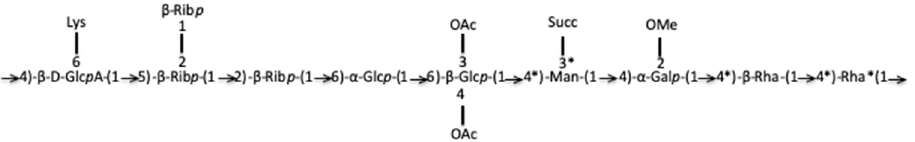
Figure 6. Partial putative structure of the purified EPS obtained from the cysts of R. tataouinensis TTB310. The C*s are those for which it is necessary to check that they are well engaged in the link. Lys: Lysine; OAc: O-acetyl group; Succ: succinate; OMe: O-methyl group.